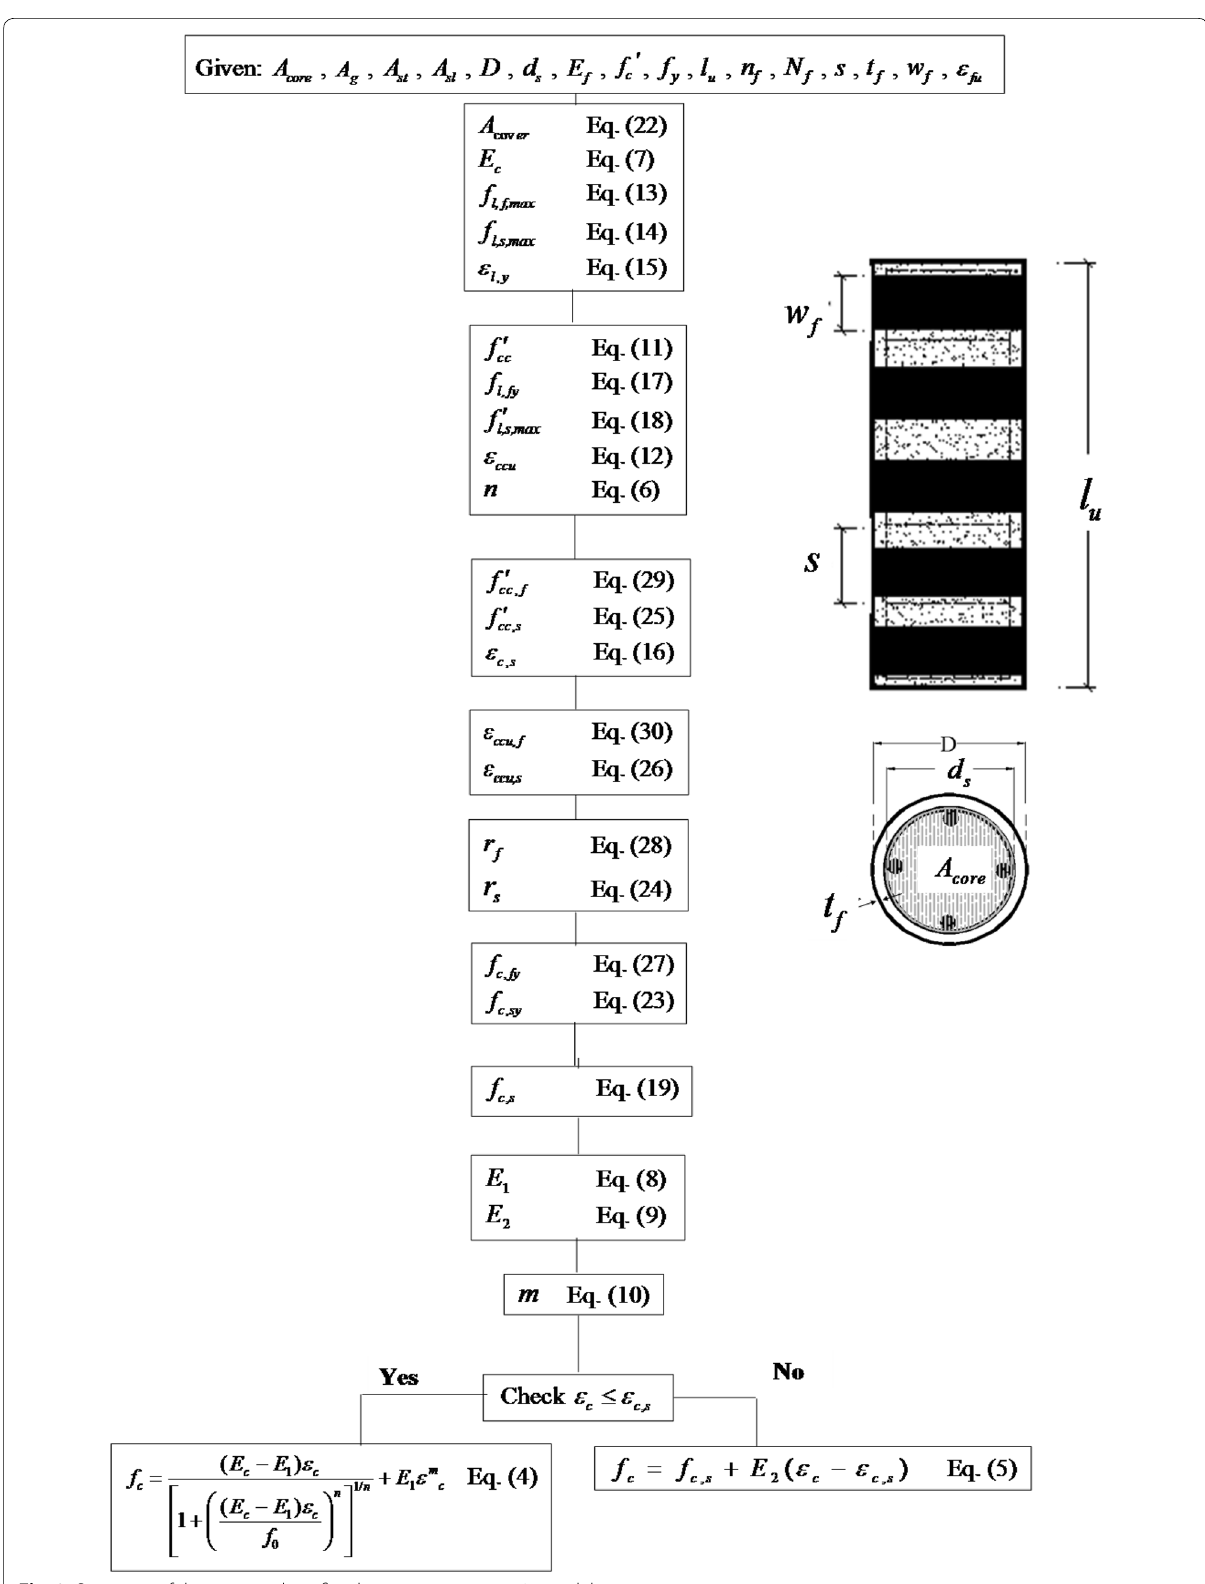
Fig. 9 Summary of the proposed confined concrete stress–strain